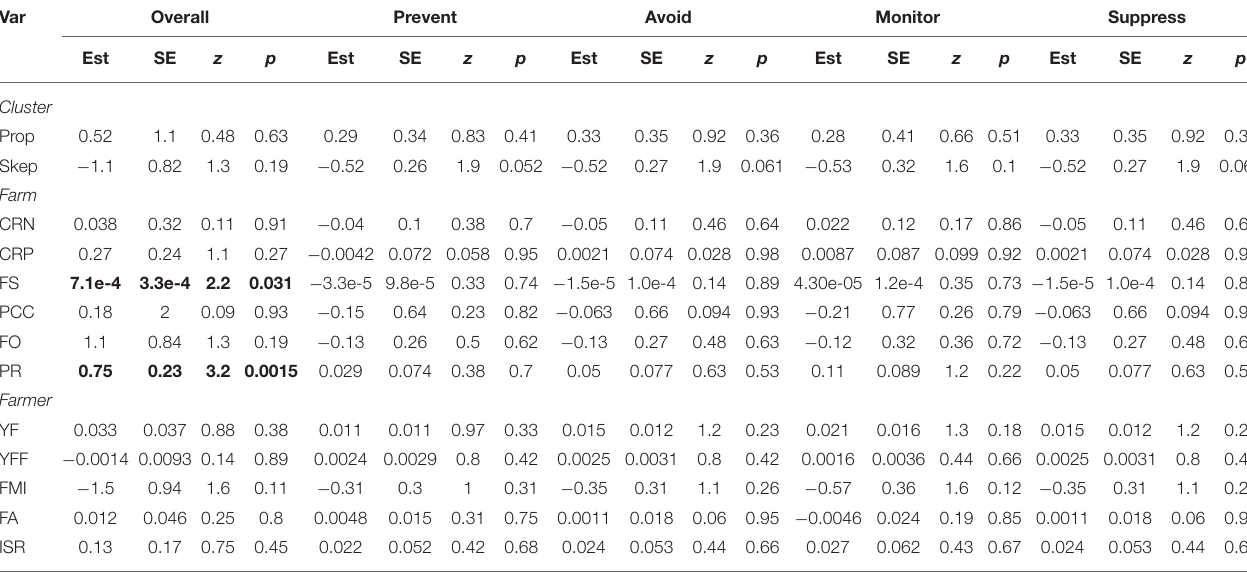
The dependent variables (columns) include overall use of IPM and the separate use of preventative, avoidance, monitoring, or suppressive measures. Explanatory variables (rows) include the farmer classifications generated by the cluster analysis, farm, and farmer characteristics. Neutral farmers from the classifications were used as the reference category. Bold text highlights correlations between the dependent and explanatory variables. Prop, Proponent; Skep, Skeptic; CRN, Crop richness not pollinated; CRP, Crop richness pollinated; FS, Farm size; PCC, Proportion cucurbit crops; FO, Farm owned; PR, Pest